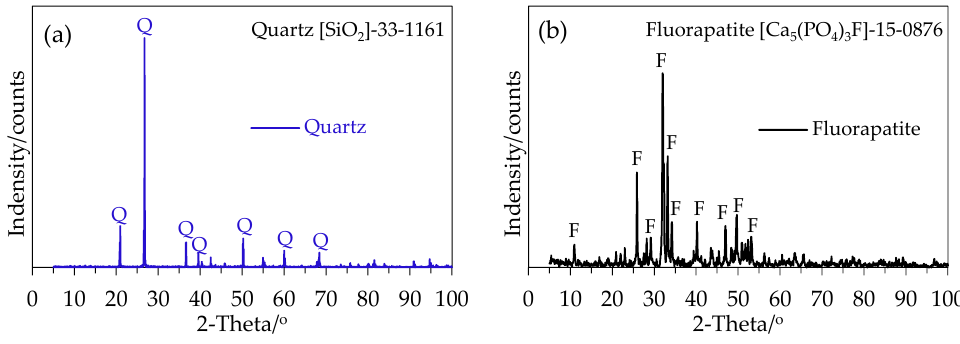
Figure 1. X-ray diffractogram of ( a ) fluorapatite, ( b ) quartz.